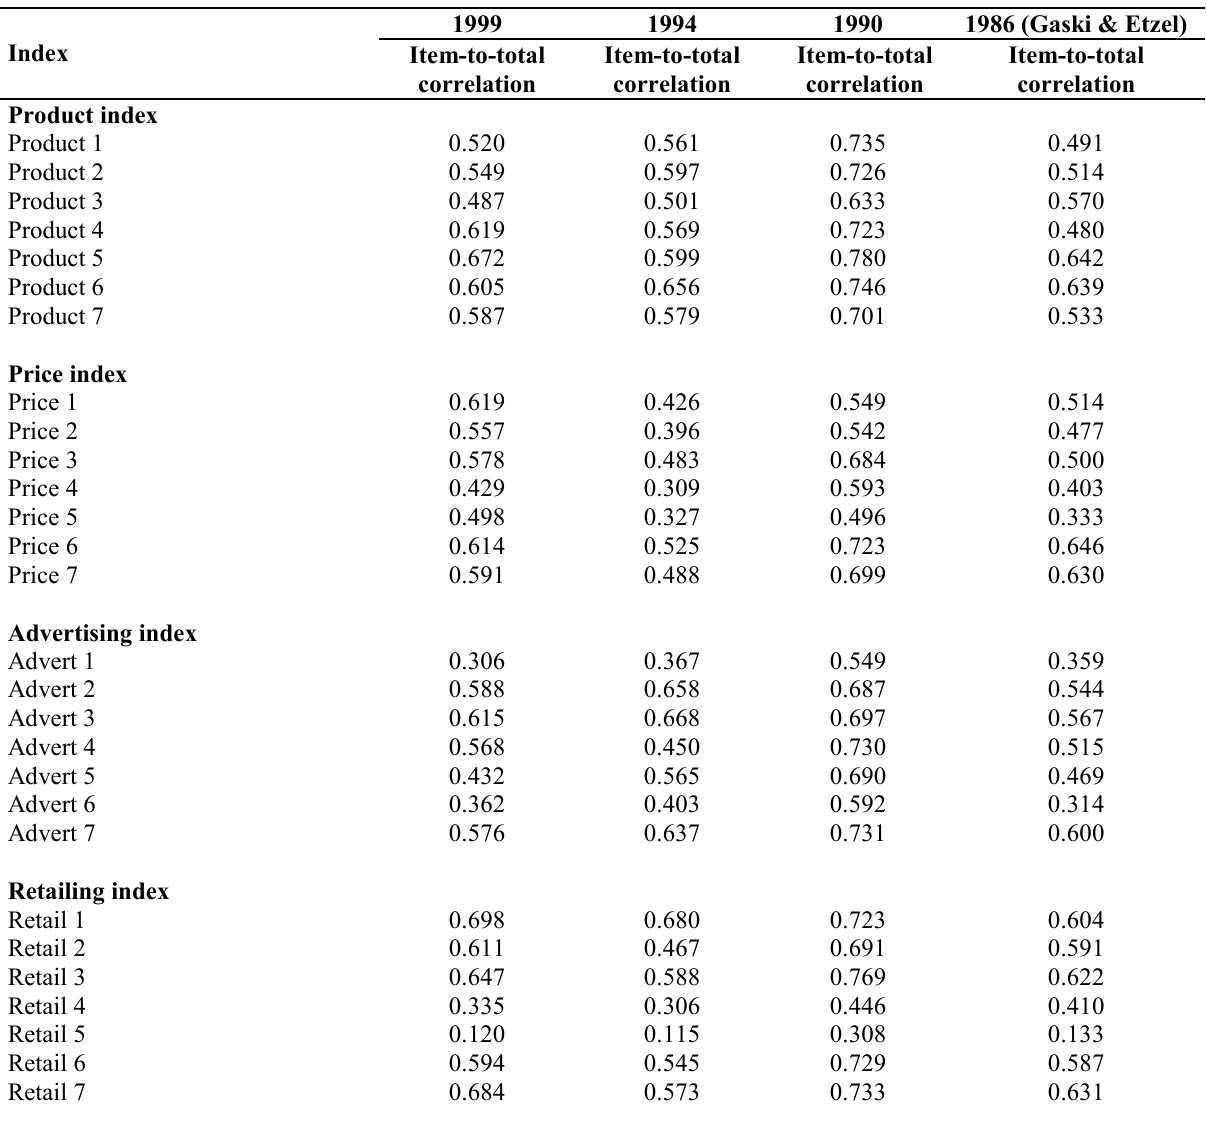
Table 2: Comparative item-to-total correlations